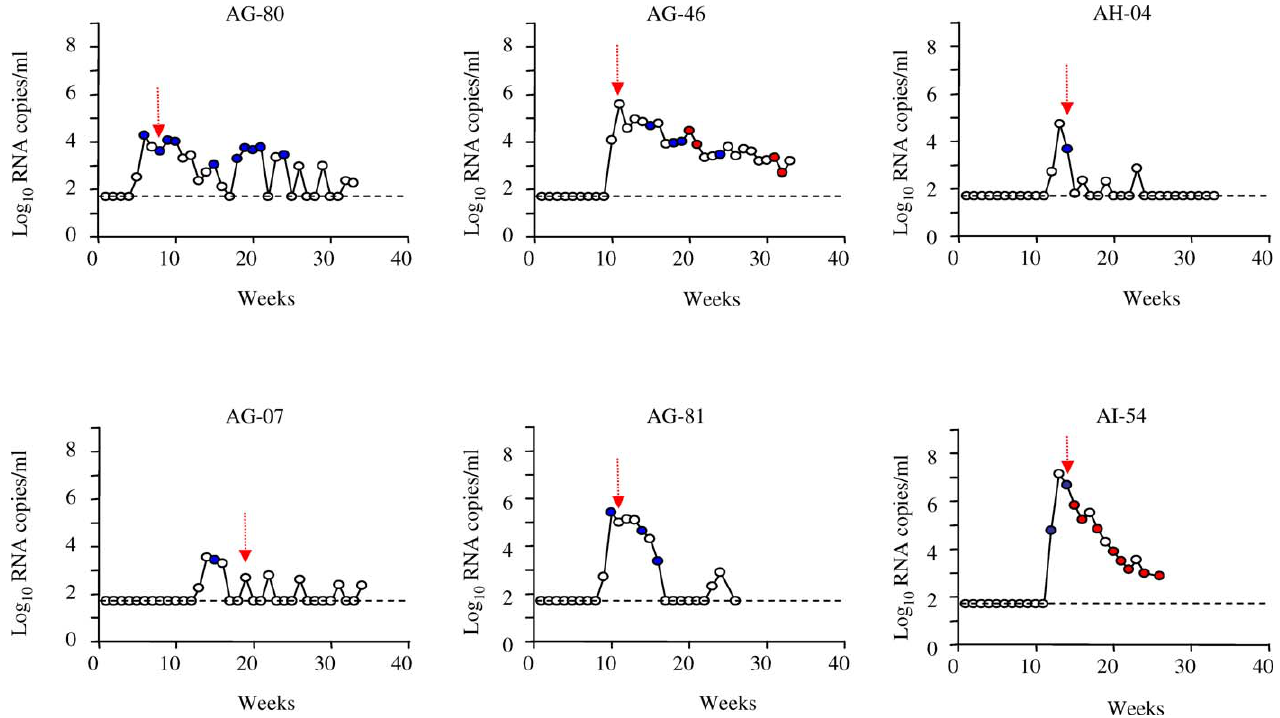
Figure 4. Dynamics of Infection in Animals Infected during PrEP with FTC (AG-80, AG-46, AH-04, and AG-07) or FTC/TDF (AG-81 and AI-54) Red circles indicate detectable M184V/I mutation; wild-type sequences are shown in blue. Open circles indicate time points that were not genotyped. The first detectable antibody response is shown as red arrows. The broken line denotes the limit of detection of the virus load assay (50